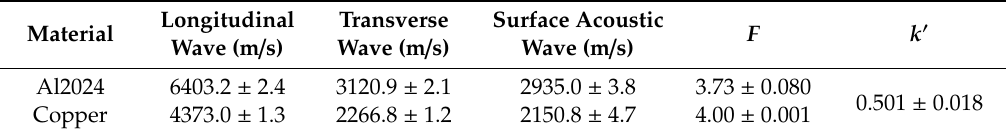
Table 2. Measurement results for wave velocities and wavenumber compensation factor.